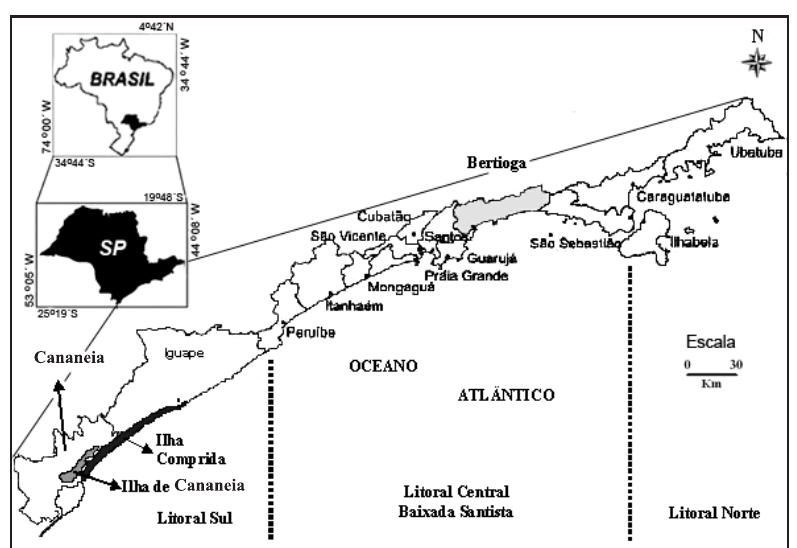
Figura 1. Localização dos municípios de Bertioga, Cananeia e Ilha Comprida, no litoral do Estado de São